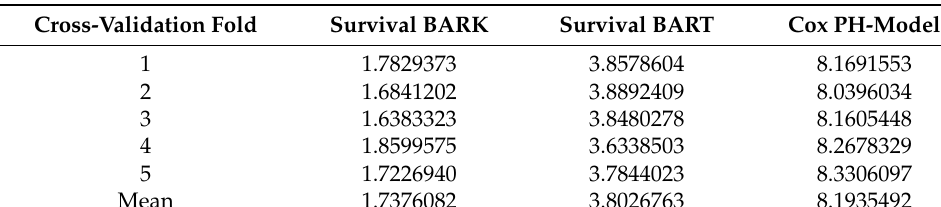
Table 3. RMSE from 5-fold cross-validation performance of Survival BARK, Survival BART, and Cox- PH Model on the 30-day Hospital Readmission Data.